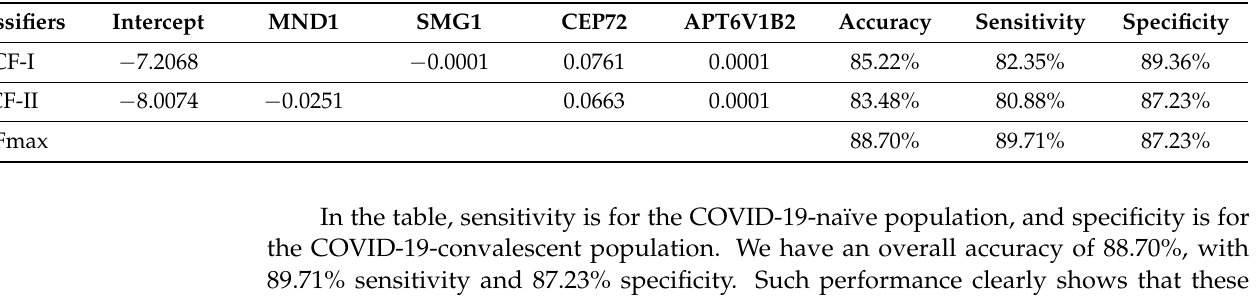
Table 6. Performance of individual classifiers and combined max-competing classifiers using